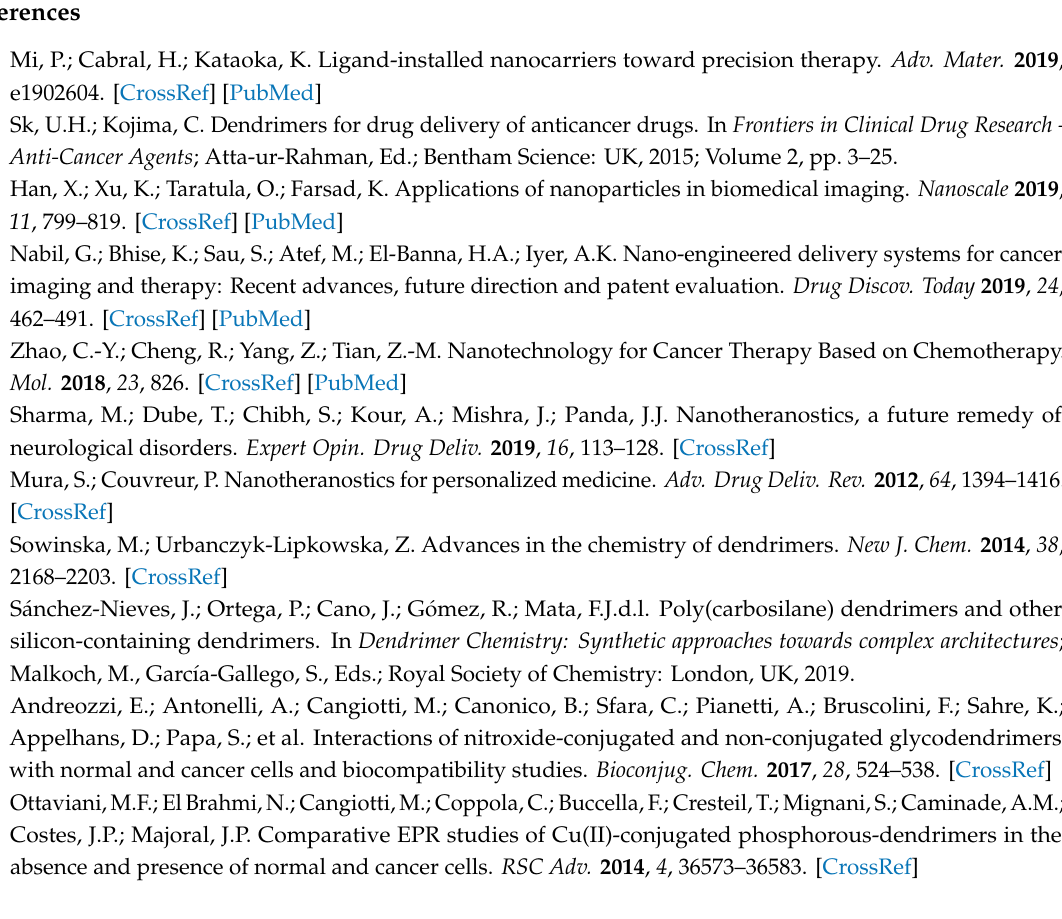
Figure S1: 1 H- and 13 C{ 1 H}-NMR spectra of compound 1 . Figure S2: TOCSY 1D spectrum of compound 1 . Figure S3: 1 H-NMR spectrum of compound 3 . Figure S4: 1 H-NMR spectrum of compound 5 . Figure S5: FT-IR spectra of precursor 4-isothiocyanateTEMPO and compound 3 . Figure S6: Examples of experimental and computed spectra of labelled dendrimers in the absence and presence of model membranes. Figure S7: Examples of experimental and computed spectra of non-labelled dendrimers in the absence and presence of model membranes. Figure S8: A zz values obtained by computing the Free and the Interacting components for CTAB for homofunctional dendrimers